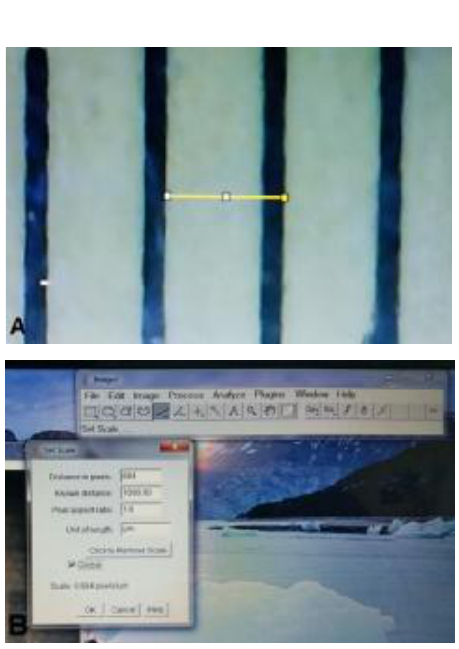
Figure 6 A and B: Calibration the measurements by set scale option. Data were collected and analyzed using SPSS (statistical package of social science) software version 15 for windows XP Chicago,